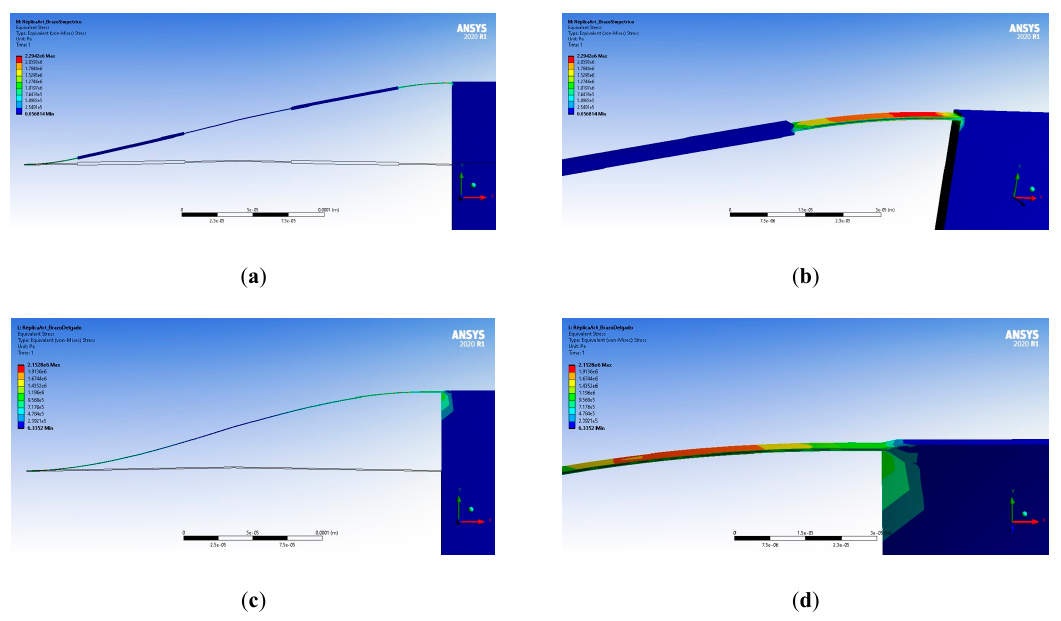
Figure 8. Simulation of stress for ( a ) the accelerometer with symmetric beams, ( b ) zoom in at one of the symmetric beams, ( c ) accelerometer with simplified beams and ( d ) zoom in at the one of the simplified beams.